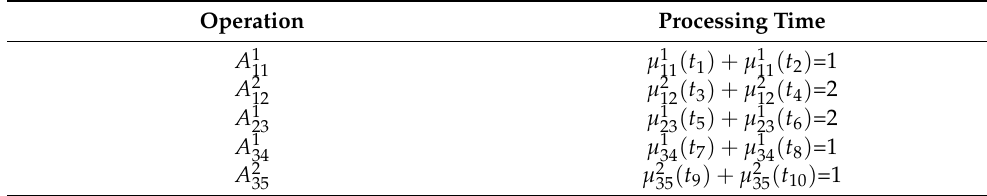
Table 4. Processing Time of Each Operation of Example